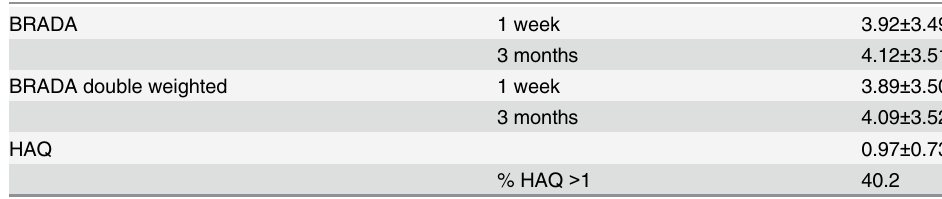
Table 3. BRADA and HAQ